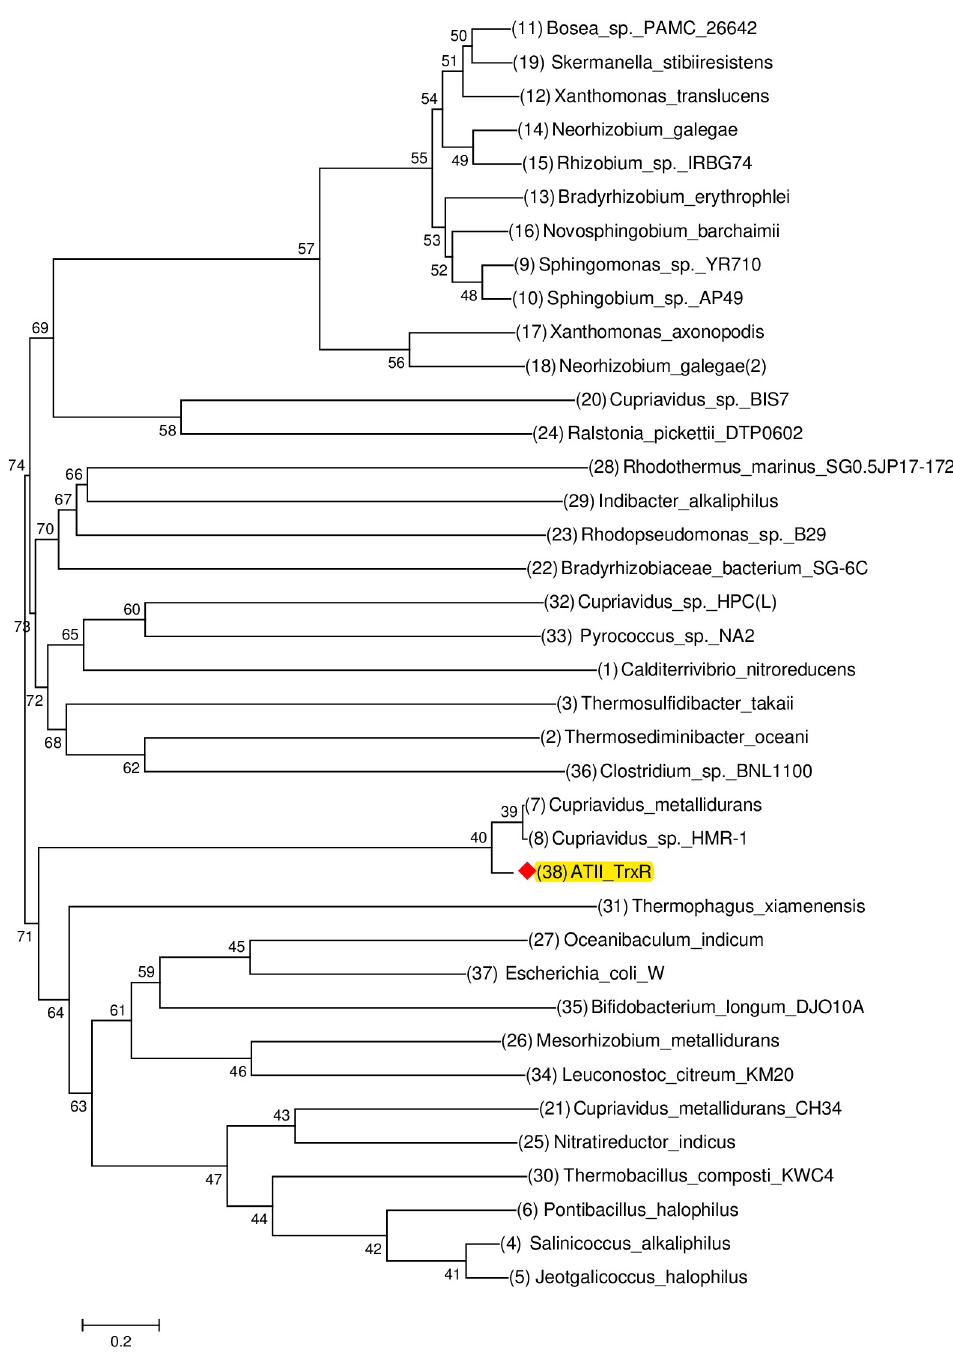
Fig 2. Phylogenetic analysis of ATII-TrxR. The evolutionary history of ATII-TrxR with thioredoxin reductases from different species was inferred using the neighbour-joining method. The tree is drawn to scale, with branch lengths in the same units as those of the evolutionary distances used to infer the phylogenetic tree. The analysis involved 37 amino acid sequences. Evolutionary analyses were conducted in MEGA7. As shown in the figure, the phylogenetic tree of the thioredoxin reductase protein sequence extracted from the LCL of Atlantis II brine pools of the Red Sea revealed that the ATII-TrxR sequence was closely related to the sequences from the heavy metal-resistant bacteria Cupriavidus metallidurans and Cupriavidus sp. HMR-1